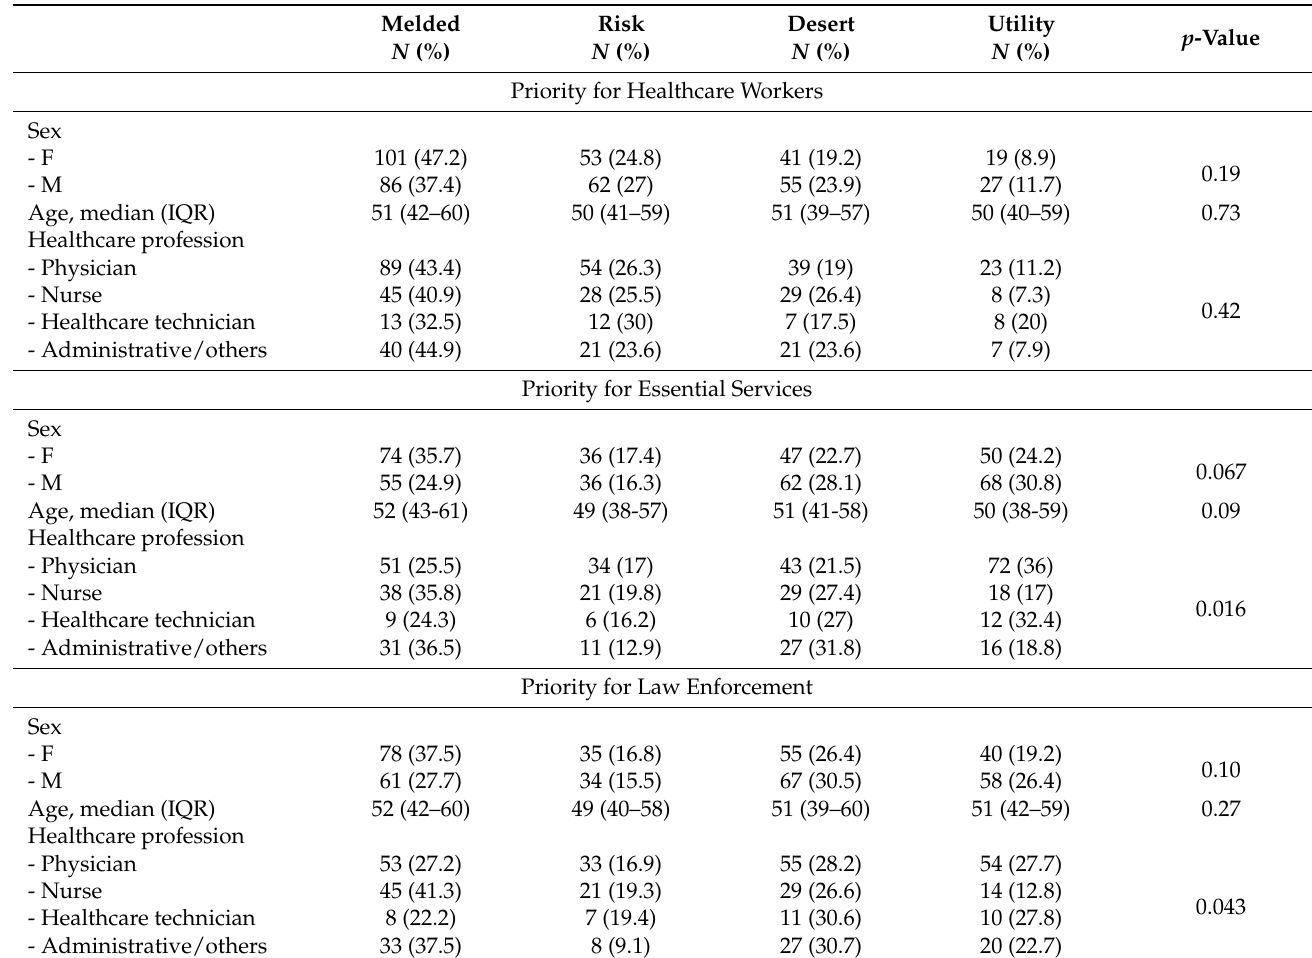
Table 3. Factors involved in perception of preferred vaccination priority strategy.